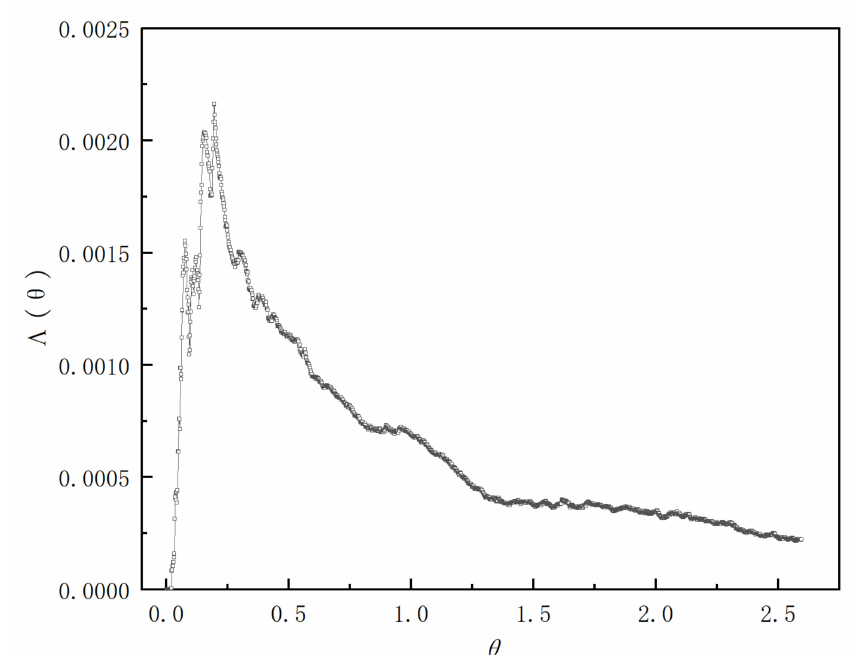
Figure 11. Overall intensity curve based on the